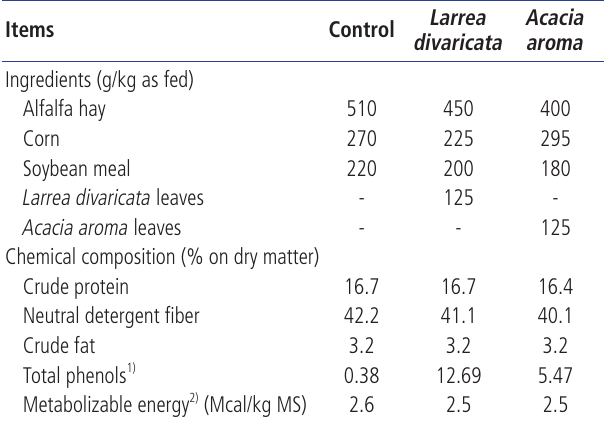
Table 1. Ingredients and chemical composition of the experimental diet